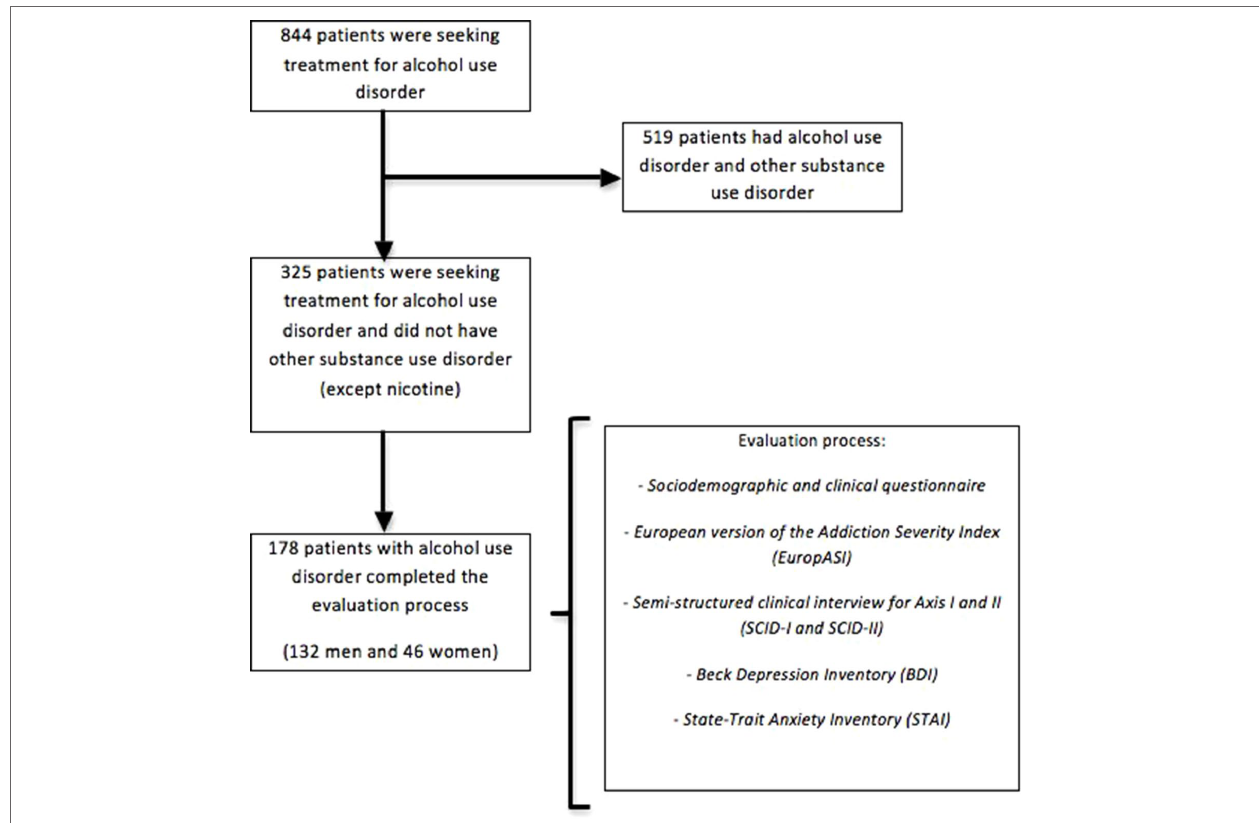
FIGURE 1 | Sample